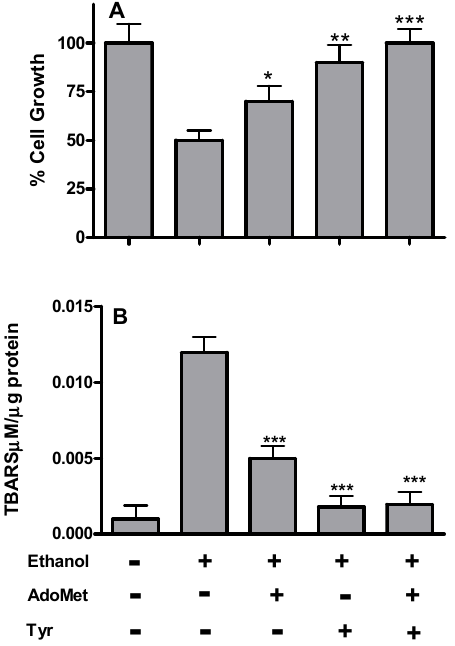
Figure 1. Effects of AdoMet and Tyr on cell viability and TBARS content of HepG2 cells after acute ethanol treatment. Cells were pretreated with 1 M ethanol for 4 h (Et-HepG2) and then incubated for 48 h with AdoMet 100 µM, Tyr 10 µM, and their combination. ( A ) cell proliferation was evaluated by MTT assay and was expressed as percent of Et-HepG2 cells; ( B ) TBARS content was assessed from HepG2 cell lysates. Values represent the mean ± SD of three experiments. * p < 0.05; ** p < 0.01; *** p < 0.001 was considered significant for ethanol alone.